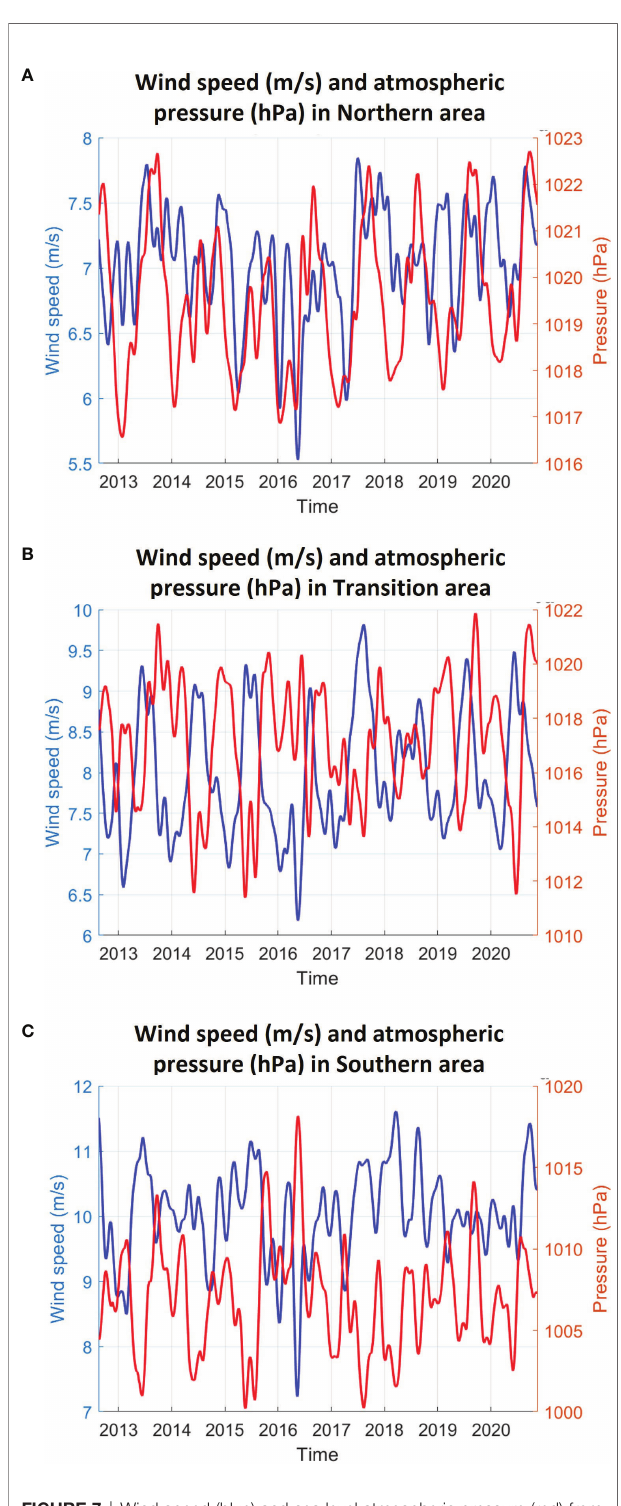
FIGURE 7 | Wind speed (blue) and sea level atmospheric pressure (red) from 2012 to 2020 for Northern (A) Transition (B) and Southern (C) areas. A 3- month Gaussian fi lter was applied to the data. For a better visualisation of the variations, y-axis ’ scales